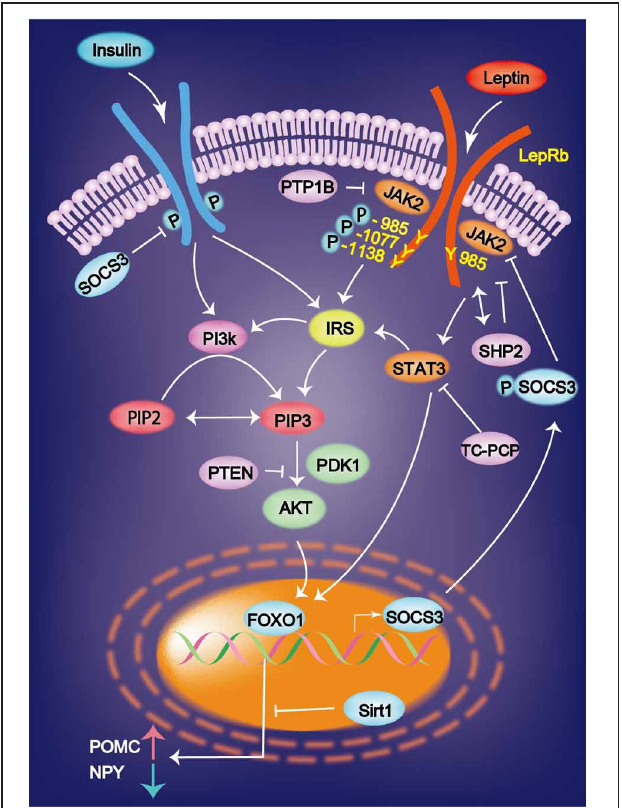
FIGURE 1 | Leptin binds to the leptin receptor (LepRb) and activates the receptor-associated kinase JAK2 via transphosphorylation and phosphorylates three tyrosine residues (Y985, Y1077, and Y1138). Leptin-induced mRNA expression of JAK-STAT is inhibited by SOCS3. Insulin and leptin regulate the expression of AgRP and POMC via Foxo1 and signal transducer and activator of transcription factor Stat3. Sirt1 suppresses the Foxo1-dependent expression of the orexigenic neuropeptide AgRP. AgRP, agouti-related protein; FOXO1, Forkhead box O1; IRS, insulin receptor substrate; PI3K, phosphatidylinositol 3 kinase; PIP3, phosphatidylinositol 3, 4, 5-triphosphate.